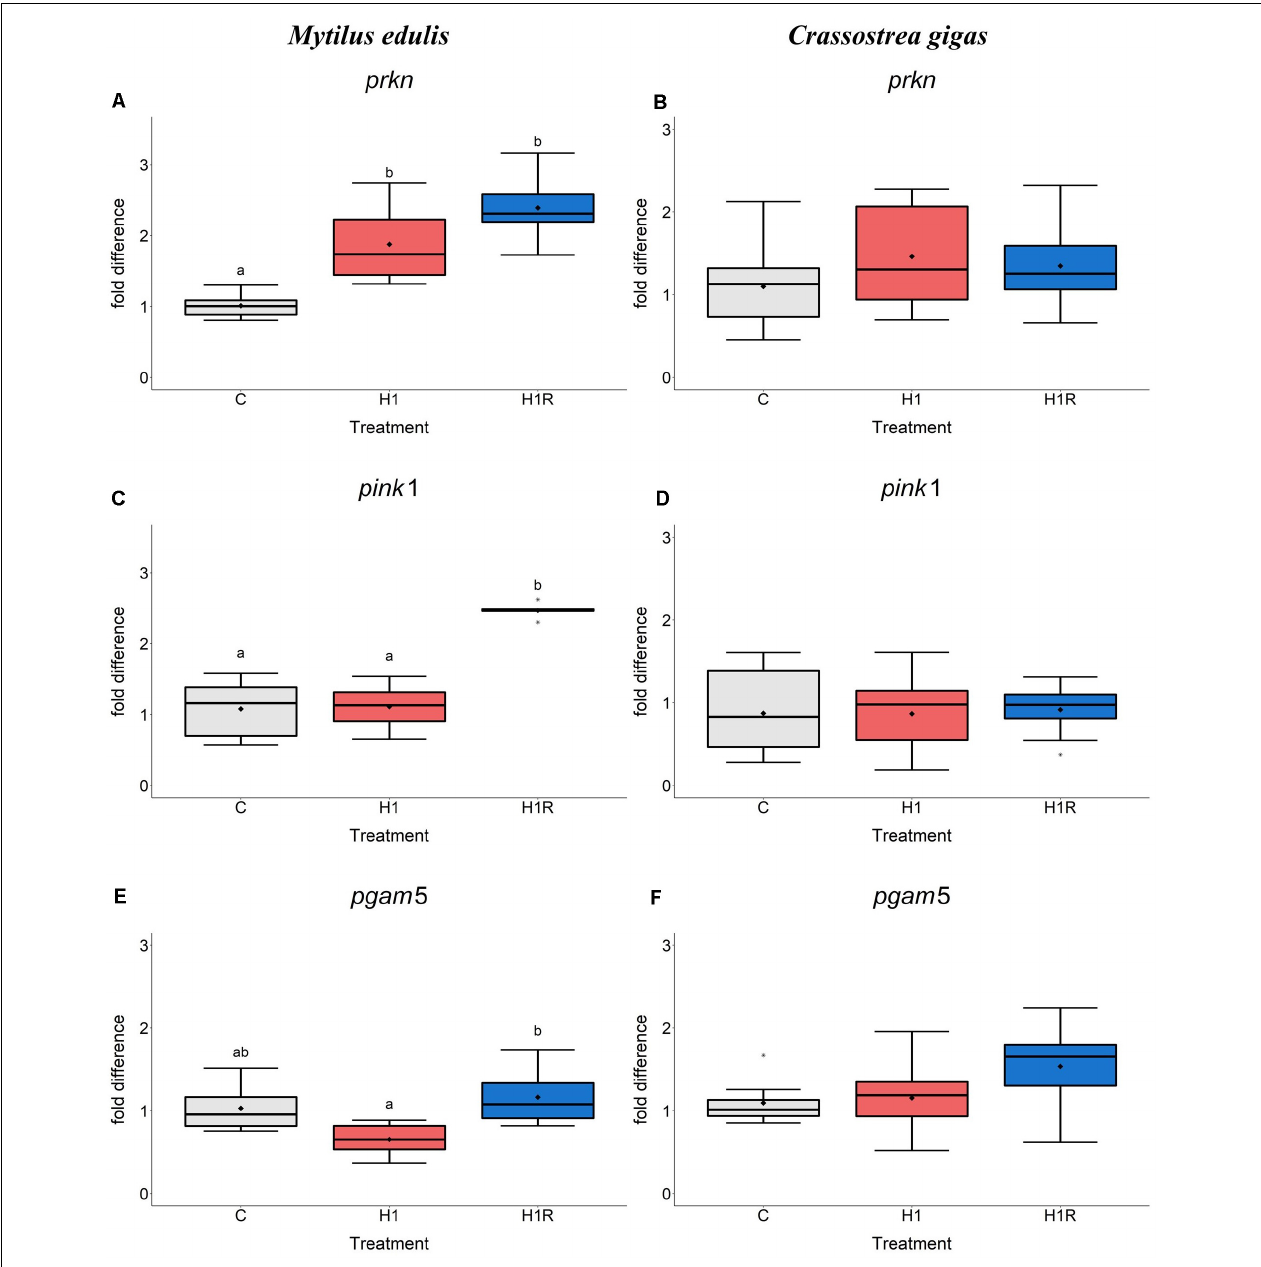
FIGURE 5 | mRNA expression of mitophagy proteins in M. edulis and C. gigas hepatopancreas in response to H/R stress. (A,C,E) M. edulis ; (B,D,F) C. gigas ; (A,B) pink 1 mRNA; (C,D) prkn mRNA, (E,F) pgam 5 mRNA. Experimental groups: C, control; H1, short-term (1 day) severe hypoxia; H1R, short-term (1 day) severe hypoxia and subsequent 1.5 h reoxygenation. Means are depicted as points within corresponding Box-Whisker-plot. Outliers are shown as asterisk (*). Different letters above plots represent values that are statistical significantly different from each other ( p < 0.05). Plots sharing a letter are not significantly different ( p > 0.05). N =